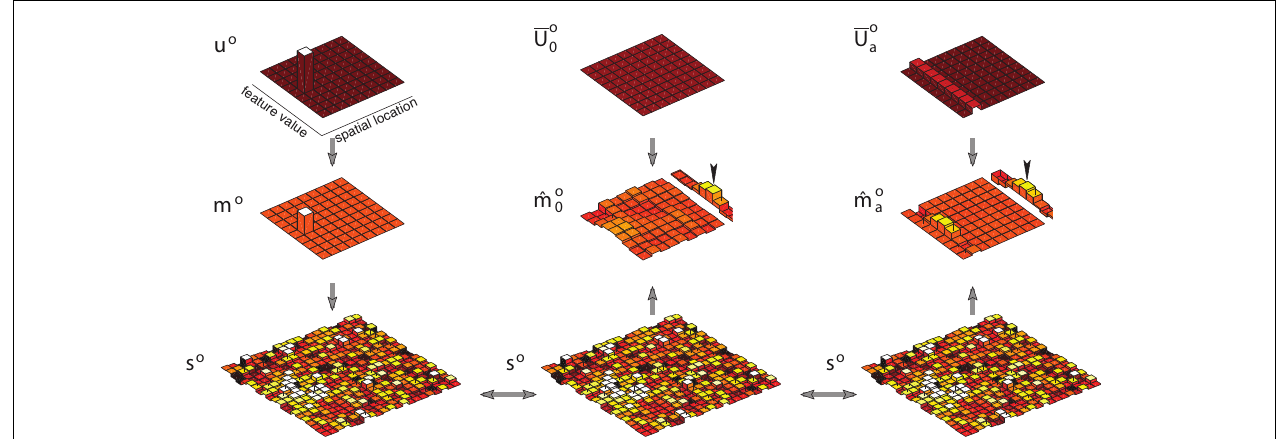
FIGURE 4 | Generation, inference, and decision in a model of precued orientation recognition. Left column: The generative process. Only orientation maps are modeled.The object ( u o ) and feature ( m o ) maps each contain a single non-zero entry, corresponding to the location, and orientation of the object shown. Sensory observations s o convey this value with a signal-to-noise ratio that reflects contrast. Center column: Inference without attention.The generated sensory observations are approximately combined with a uniform distribution over object location, leading to equal values for each location-orientation pair on the diagonal of the matrix ¯ U o